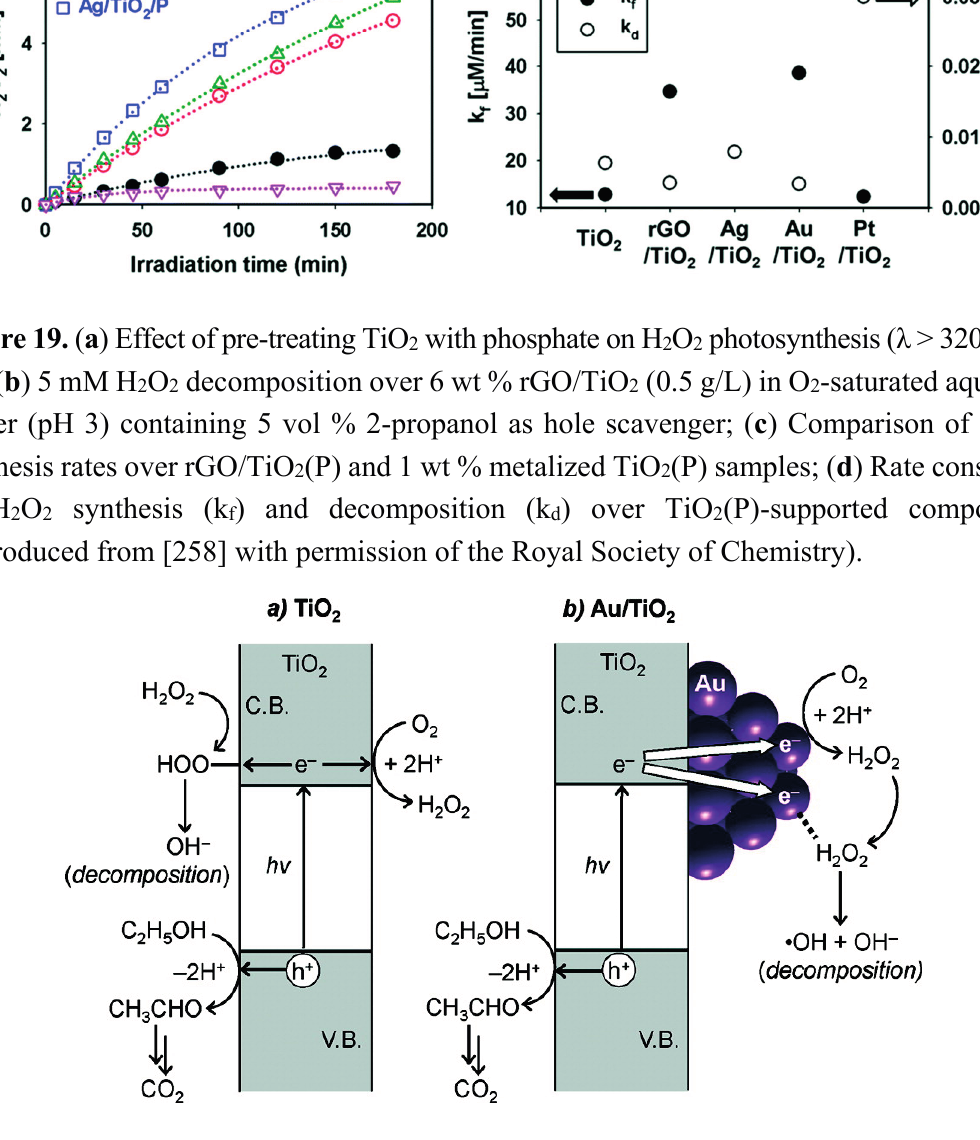
Figure 20. Scheme of synthesis and decomposition of H 2 O 2 on ( a ) TiO 2 ; and ( b ) Au/TiO 2 photocatalysts. (Reproduced from [259]. Copyright (2012) American Chemical